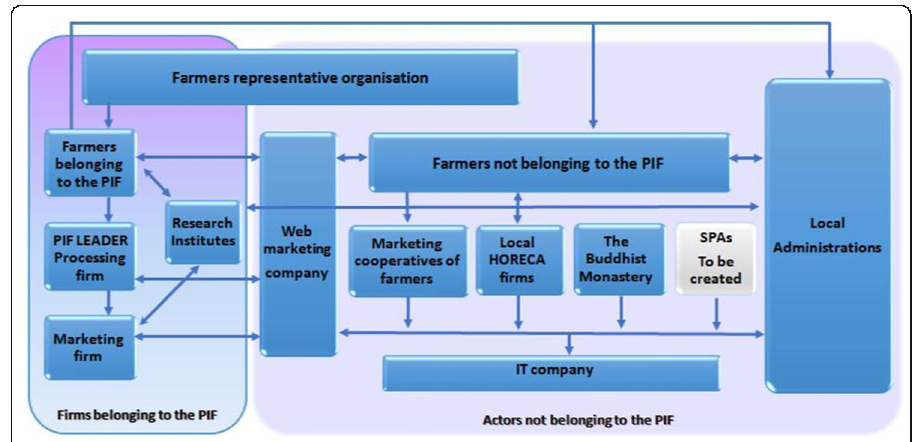
Fig. 1 The actors ’ network. Source: our elaboration on direct